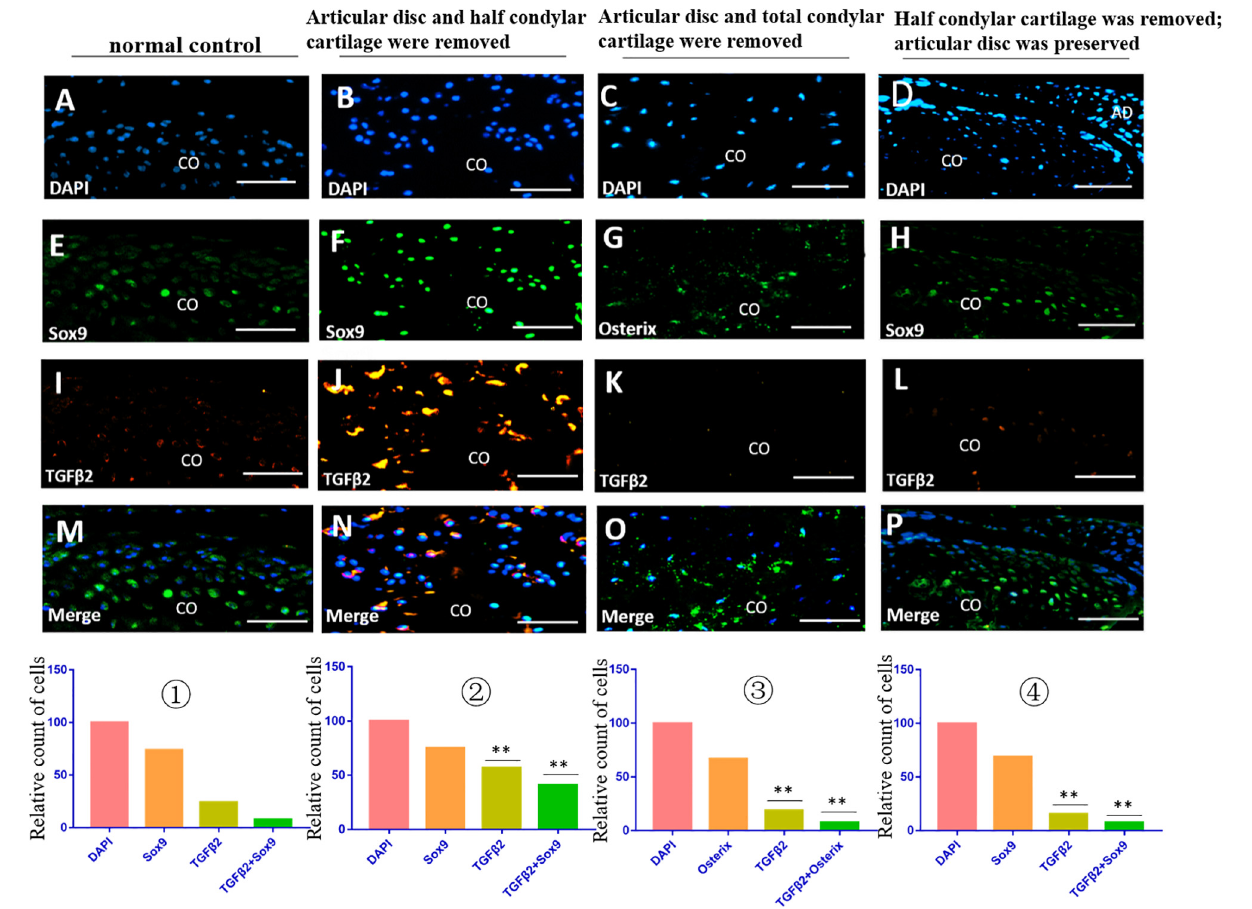
FIGURE 6 | TGF β 2/Sox9 and TGF β 2/Osterix immunofluorescence double staining in the TMJ in different animal models. (A–D) DAPI staining. (E,F,H) Sox9 staining. (G) Osterix staining. (I–L) TGF β 2 staining. (M–P) Merged image of DAPI, Sox9/Osterix, and TGF β 2 staining. (cid:172) The cell counts of different markers in the normal TMJ, with the count of DAPI accepted as 100 and the counts of other markers calculated and compared with the count of DAPI. (cid:173) The relative counts of TGF β 2-positive cells and costained cells were higher in the injured condylar cartilage in the first animal model than those in the normal TMJ ( ∗∗ p < 0.01). (cid:174) The relative counts of TGF β 2-positive cells and costained cells were lower in the injured subchondral bone in the second animal model than those in the first animal model ( ∗∗ p < 0.01). (cid:175) The relative counts of TGF β 2-positive cells and costained cells were also lower in the injured condylar cartilage in the third animal model than those in the first animal model ( ∗∗ p < 0.01). AD, articular disc; CO, condyle. Scale bar: 50 µ